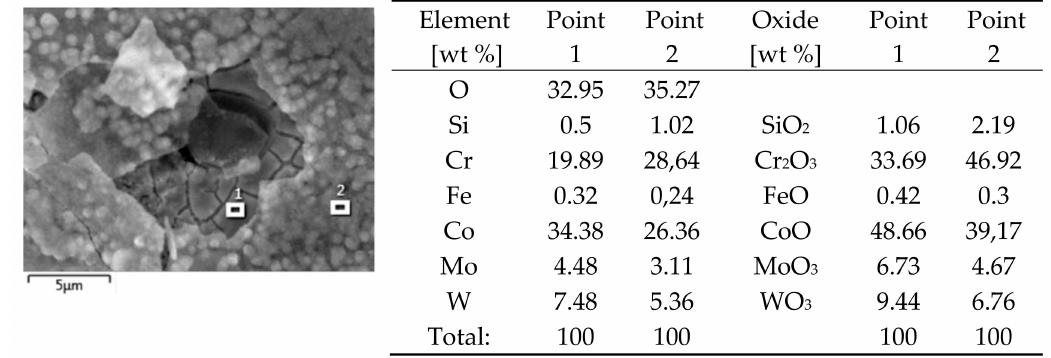
Figure 11. Results of EDS point analyses for the CST2 sample after corrosion examinations with a chart comparing oxide content.